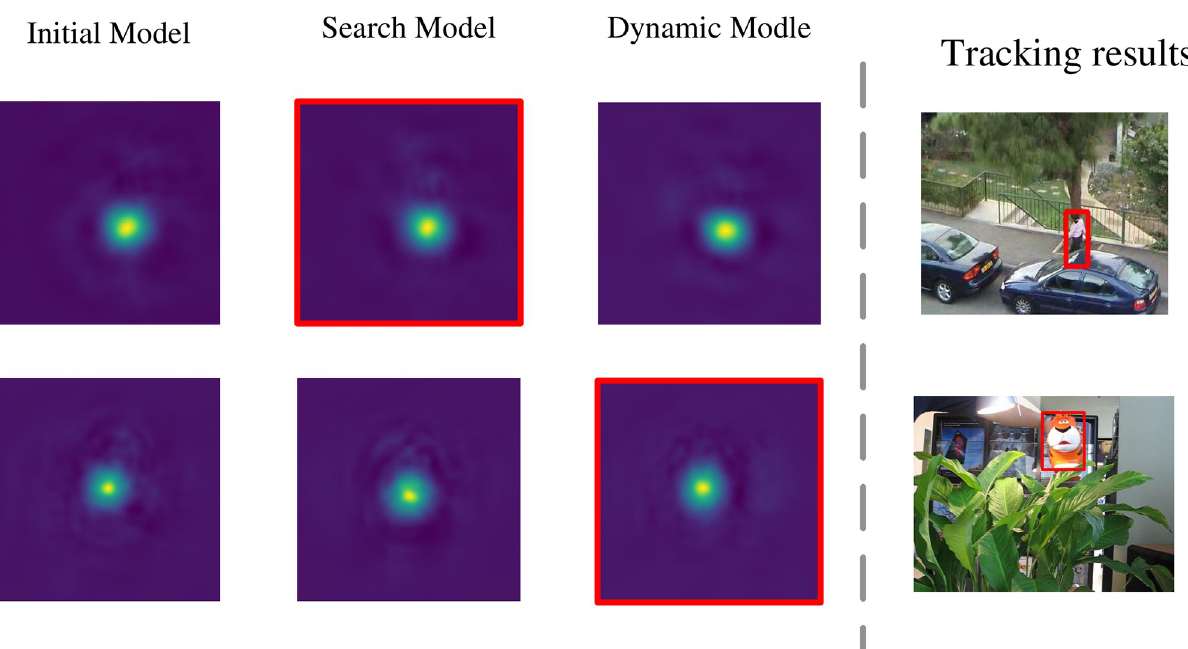
Fig 9. Visualization of response maps of different correlation filtering models. Selected models surrounded by red boxes. The results from top to down are Woman and Tgier1 from OTB-2015.